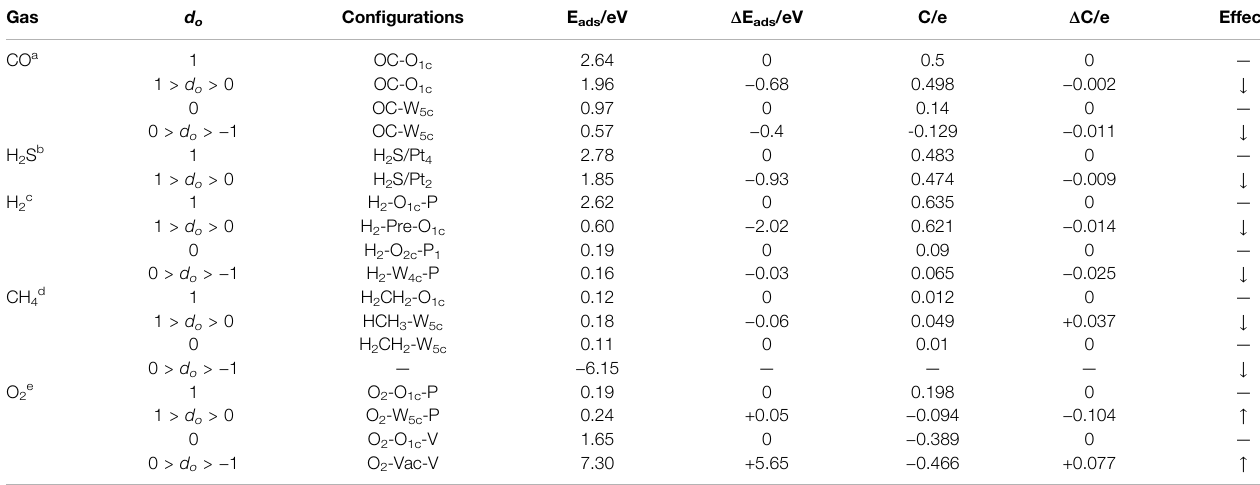
TABLE 5 | The adsorption energy and charge transfer of O 2 , CO, H 2 , H 2 S, and CH 4 on 2D h-WO 3 (001) surface with oxygen vacancy ( d o is surface oxygen density, C is charge transfer, Δ C is the variation of charge transfer, ↑ is promotion, ↓ is reduction).